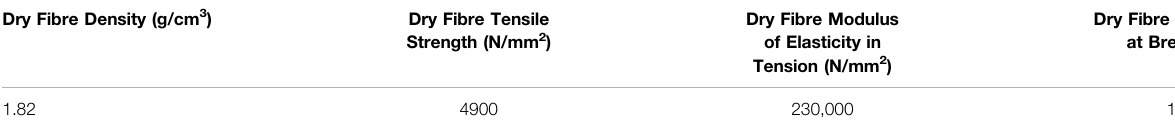
TABLE 1 | Mechanical properties of CFRP, taken from Sika (SikaWrap, 2017).